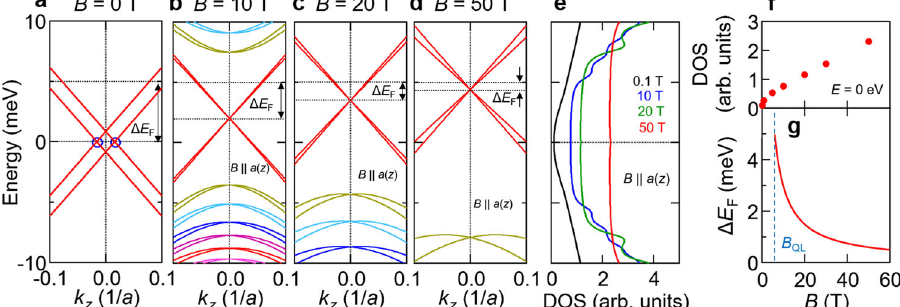
Fig. 3 Calculation of Landau levels of the line node. a Calculated energy dispersion near the line node. The band crossing due to the line node is denoted by blue circles. Here the origin is U-point in the momentum space [See Supplementary Fig. 9]. b , c , and d Landau levels around the U-point under the magnetic fi eld of 10, 20, and 50 T, respectively. The magnetic fi eld is applied along a -axis of the crystal ( B || a ( z )). e Density of states at B = 0.1, 10, 20, and 50 T. f The density of states at 0 eV as a function of the magnetic fi eld. g The magnetic fi eld dependence of Δ E F . The de fi nition of Δ E F is shown in a , b , c , and d